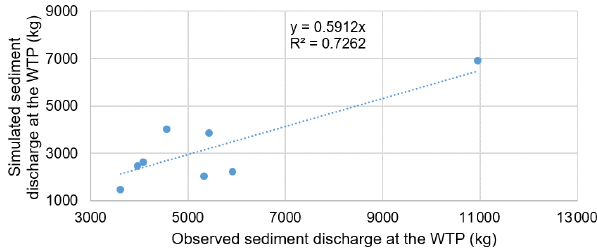
Figure D1. Scatter plot of the observed versus simulated sediment discharge by the DNN at the WTP for the 1% highest sediment discharge on